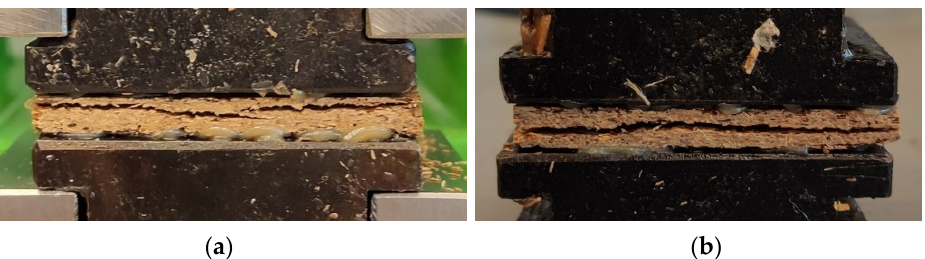
Figure 4. Internal bond (IB) of tested lignocellulosic composites.